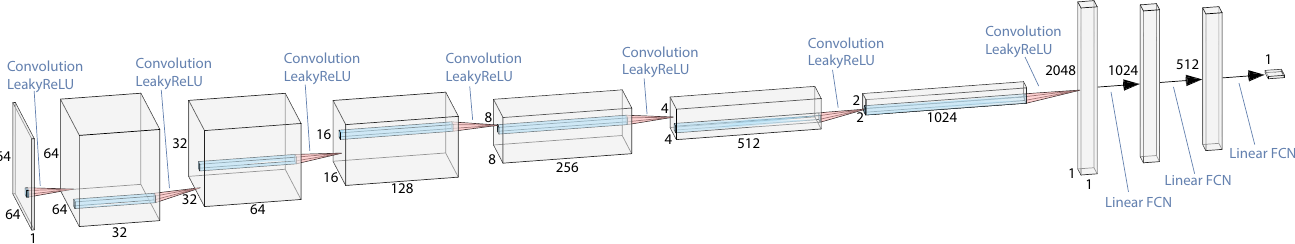
Figure 8. The Convolutional Neural Network (CNN) regression network architecture. It consists of seven convolution layers, followed by three fully connected